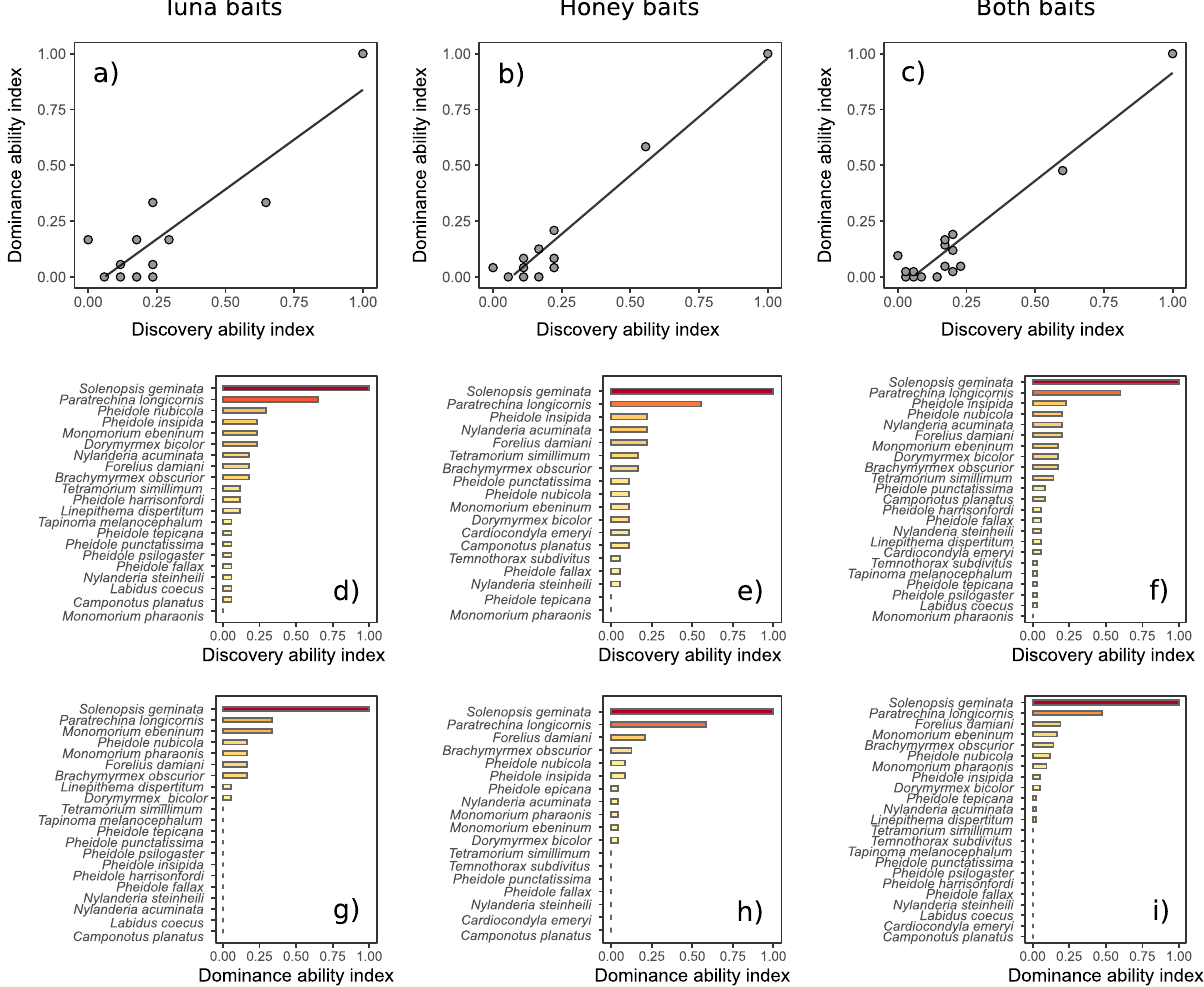
Figure 3. Relationship between the discovery and dominance ability indices involving ants sampled in ( a ) tuna (Spearman’s rank correlation. r 2 = 0.89, p < 0.001) and ( b ) honey baits (Spearman’s rank correlation. r 2 = 0.88, p < 0.001), and ( c ) when both baits were considered together (Spearman’s rank correlation. r 2 = 0.96, p < 0.001). Throughout the letters ( d )–( i ) the distribution of the values of the discovery and dominance ability indices for each ant species represented in the relationships of ( a )–( c ) are